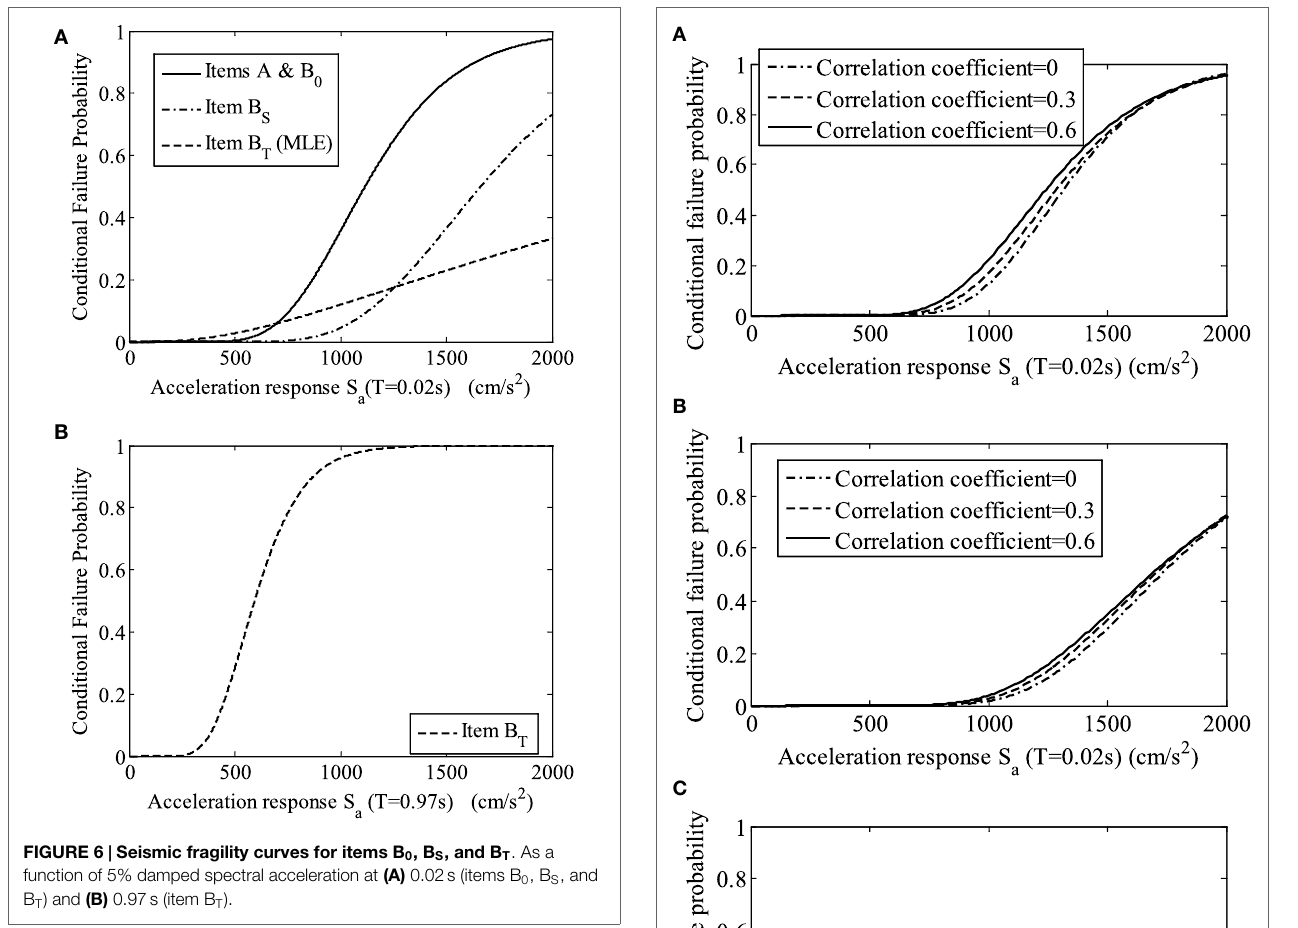
TABLE 4 | Most probable source characteristics and the most probable ground motion parameters that may cause accidents .